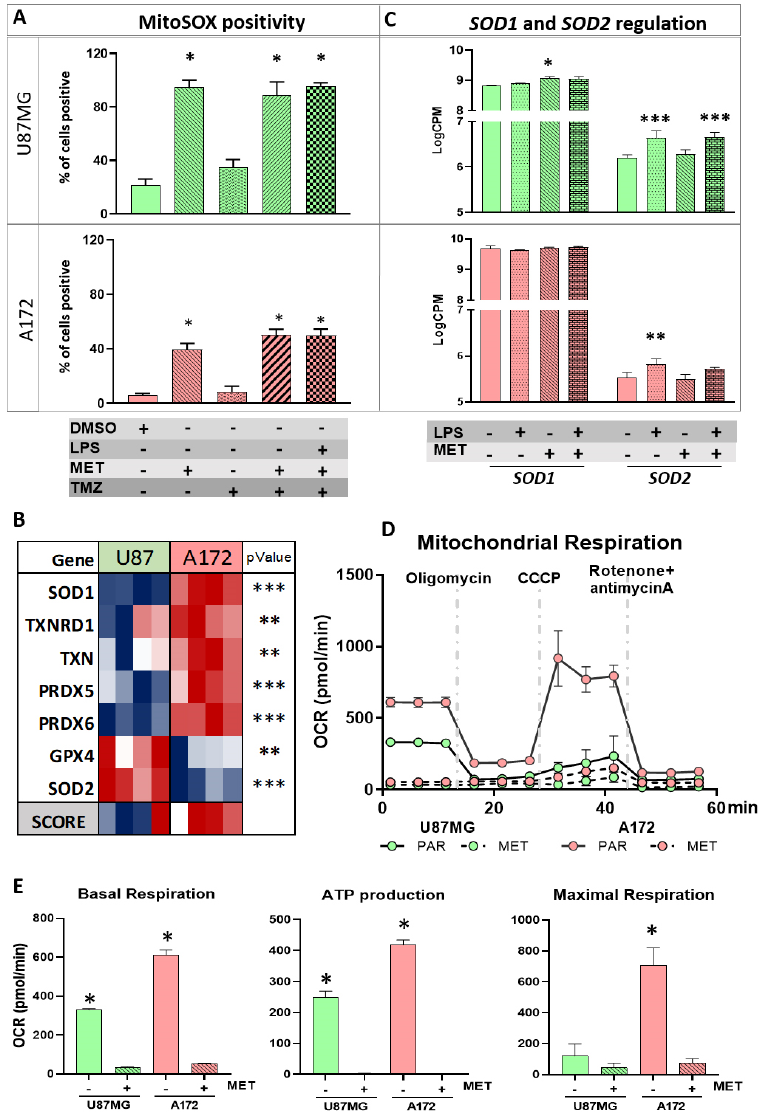
Figure 4. Mitochondrial stress. ( A ) The superoxide production in mitochondria after LPS, MET, and TMZ single and combined treatments for U87MG and A172. Graph bars represent the percentage of positive cells for MitoSOX. (*) p < 0.0001, One − wayANOVA post hoc Tukey test; (B ) heatmap presenting the expression levels of antioxidant-related genes in U87MG and A172 cells. Presenting score values for the pathway for both cells (**) p < 0.01, and (***) p < 0.001, Limma t − test; ( C ) values for logCPM for SOD1 and SOD2 represented by the graph bars for U87MG and A172 after LPS, MET and LPS+MET treatment (*) p < 0.05, (**) p < 0.01, and p < 0.001, Limma t − test; ( D ) mitochondrial respiration by Seahorse, following the mitochondrial stress analysis. The oxygen consumption rate (OCR) curves along the time interval up to 60 min are presented according to applied drugs; and ( E ) histograms of basal respiration calculated by OCR before oligomycin incubation; ATP production evaluated by oligomycin − OCR subtracted from baseline cellular rate and maximal mitochondria respiration calculated as the value after CCCP − OCR subtracted from the value after rotenone- and antimycin A − OCR for U87MG and A172 in non-treated and MET treated. (*) p < 0.0001, one − way ANOVA followed by Tukey test. Red (parental-PAR), blue (MET treated) for U87MG and lilac (PAR), green (MET treated) for A172. The antioxidant genes expressed in mitochondria were evaluated in U87MG and A172 parental cells to better understand the observed difference between the two cell